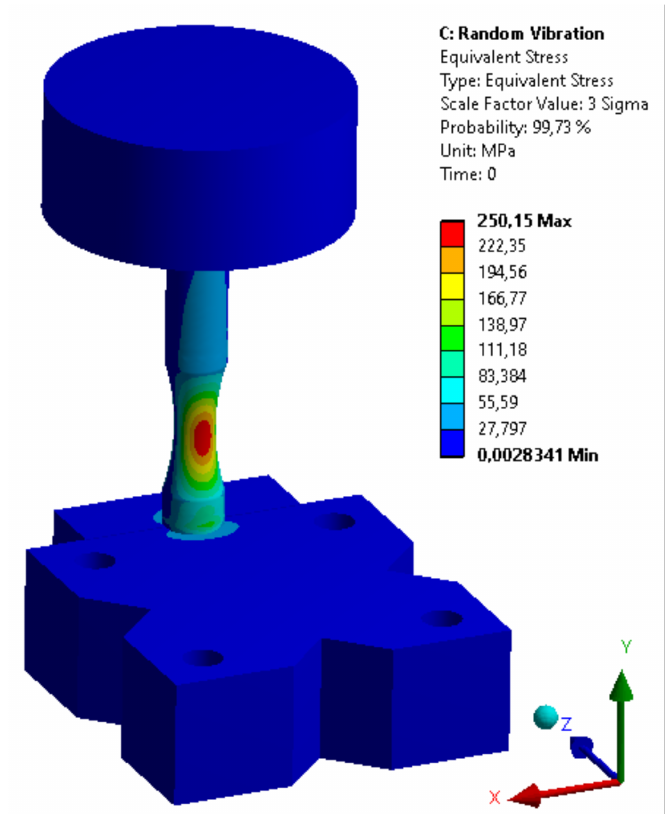
Figure 7. Numerical model used for fatigue analysis for the Ansys Workbench.